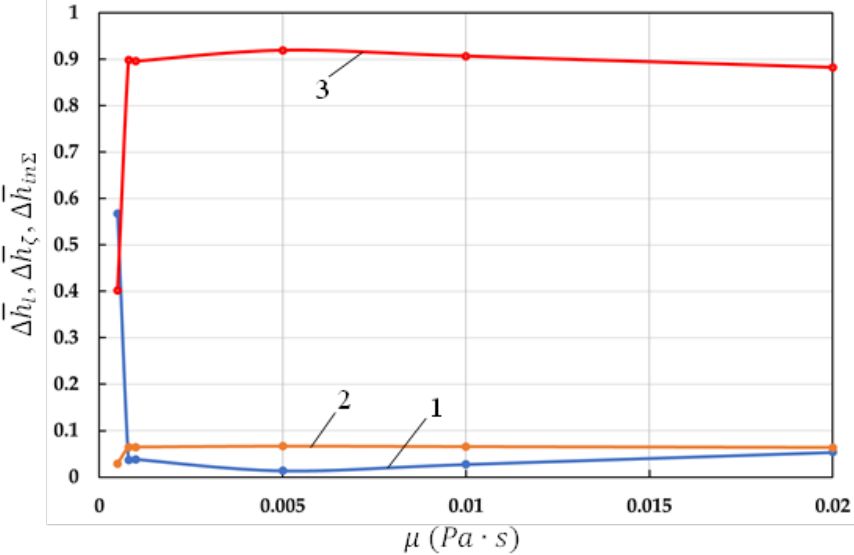
Figure 9. Dependence of the relative pressure losses along the length, to overcome local resistances and inertia forces on the dynamic viscosity coefficient (1- ∆ h l ; 2- ∆ h ζ ; 3- ∆ h in Σ ).